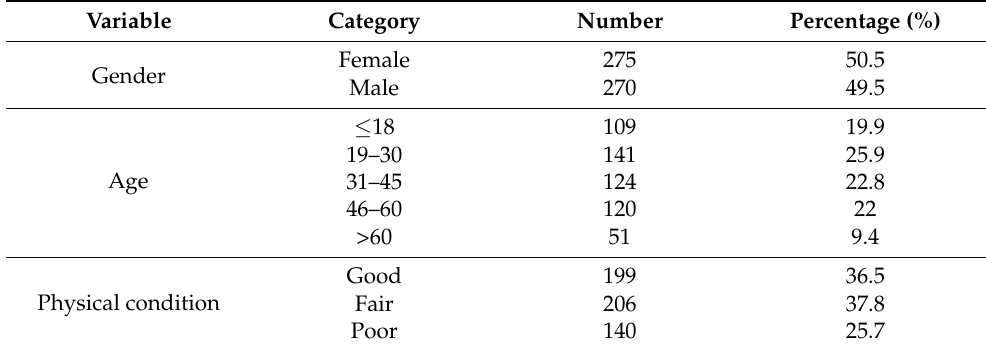
Table 1. Socio-demographic characteristics of respondents (N = 545).